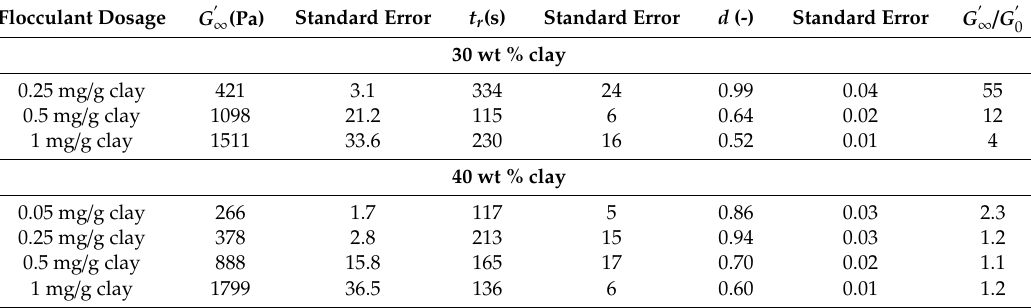
Figure 13. Normalized storage modulus as a function of time, after the pre-shearing step, for di ff erent clay suspensions having ( a ) 30 wt % and (b ) 40 wt % clay with di ff erent amounts of anionic flocculant, solid lines represent the empirical model fitting. Table 3. The values of the fitting parameters of Equation (4) for anionic polyelectrolyte based clay